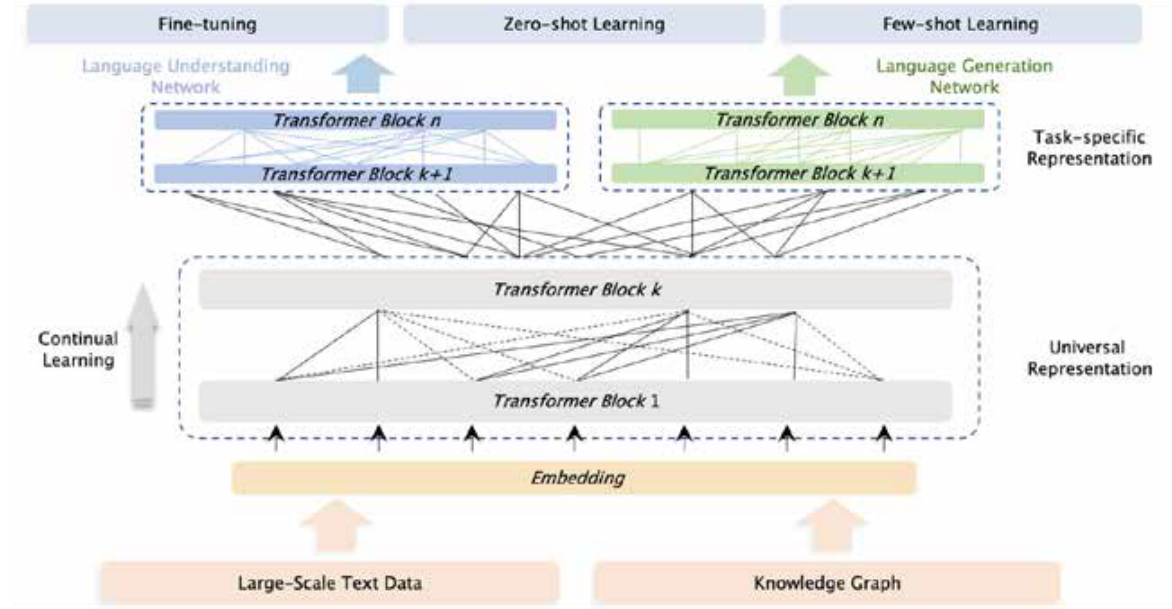
Figure 4 The model uses knowledge graphs and large-scale text as unsupervised corpus. Different languages processing tasks (NLU and NLG) share the same underlying abstract features, with a task-specific networks at the top layer. In terms of methodology, ERNIE3.0 inherits the continuous learning used Figure 1: The framework of ERNIE in ERNIE2.0, and enabling the encoding of lexical, syntactic and semantic information across tasks [17].